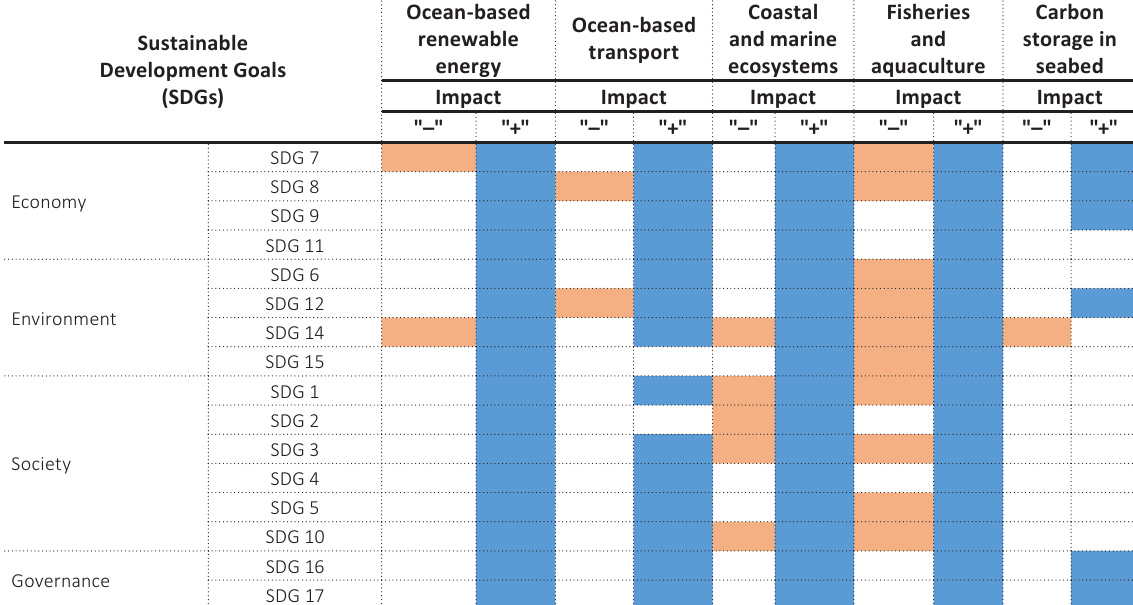
Table 1. Impact of the ocean-based climate actions on the achievement of SDGs Source: Compiled by the author based on Hoegh-Guldberg